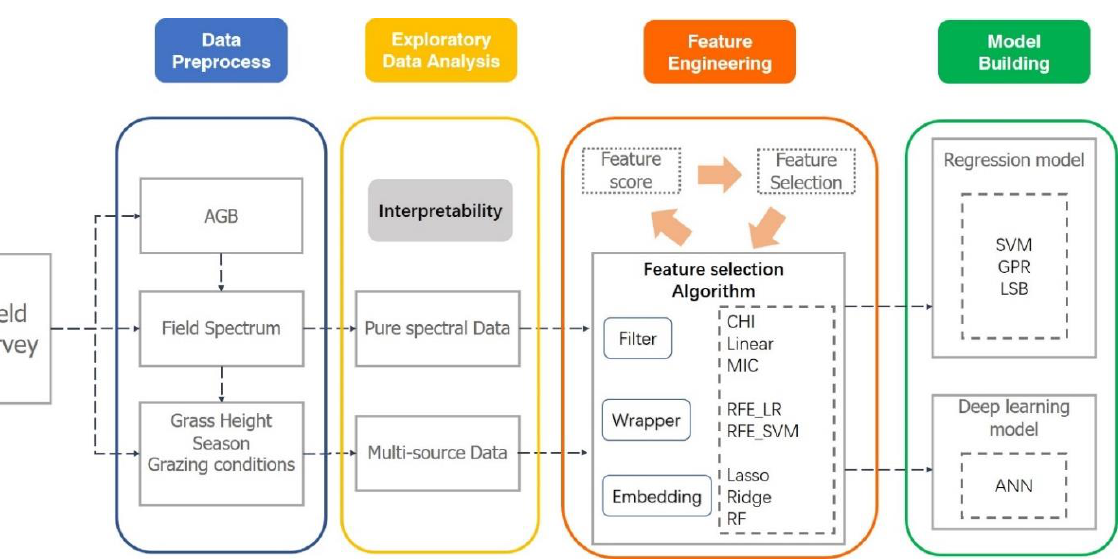
10 of 28 Figure 3. Interpretability framework based on SHAP values.